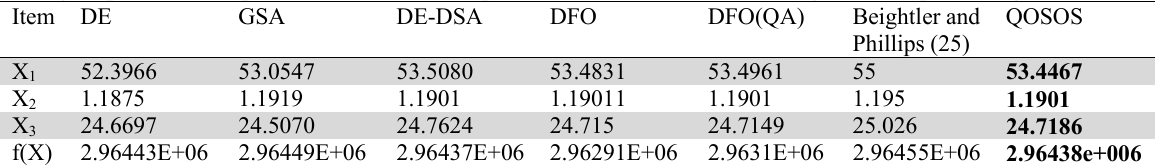
Performance results of DE, GSA, DE-GSA, DFO and QOSOS on gas transmission compressor design optimization problem. Boldface represents the best result among the compared algorithms